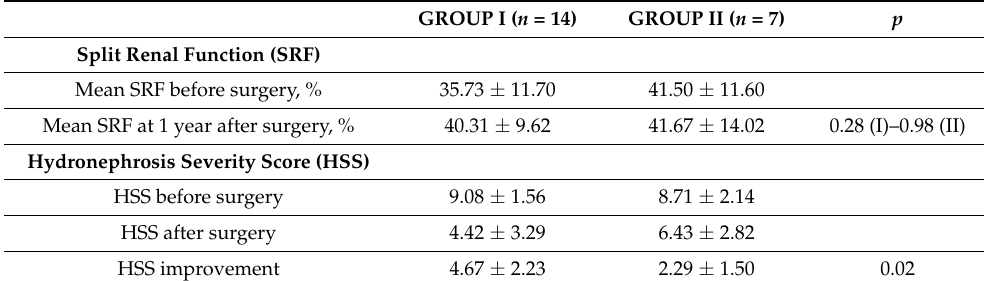
Figure 6. Urinary flow, after surgery, evaluated with renogram (wash-out, expressed with T/2). Table 3 represents the “hydronephrosis severity score” (HSS), before and at 1 year after surgery. In Group 1 the mean preoperative HSS of 9.08 ± 1.56 improved to a mean post-operative HSS of 4.42 ± 3.29. In Group 2 the mean preoperative HSS of 8.71 ± 2.14 slightly improved to a mean post-op- erative HSS of 6.43 ± 2.82. In fact, in Group 1, the mean postoperative reduction in HSS was 4.67 ±